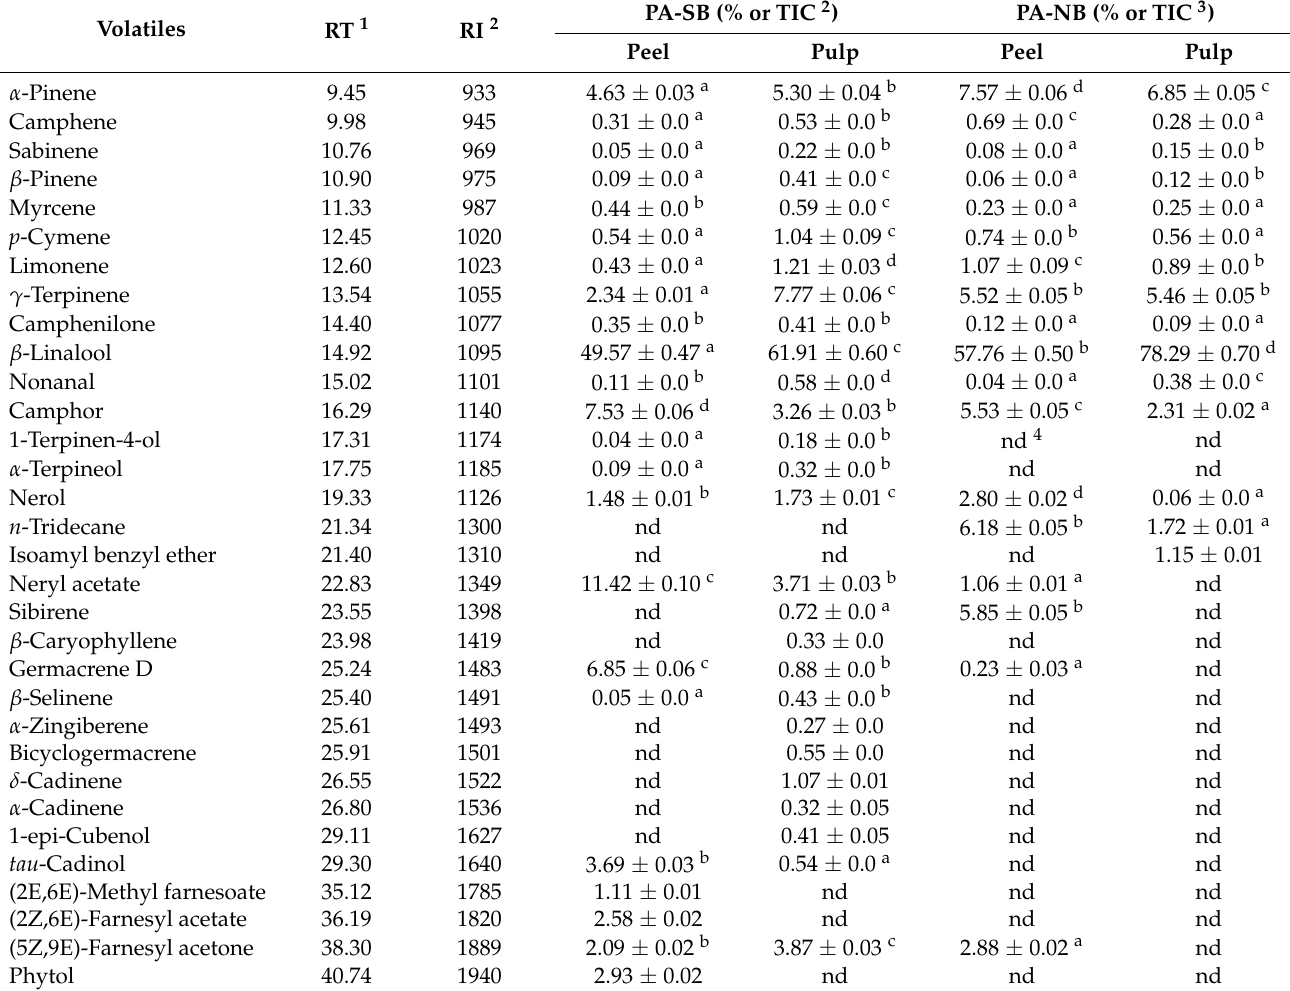
Table 8. Volatile components obtained by GC-MS in the concretes from two phenotypes of P. alkekengi (PA-SB and PA-NB)